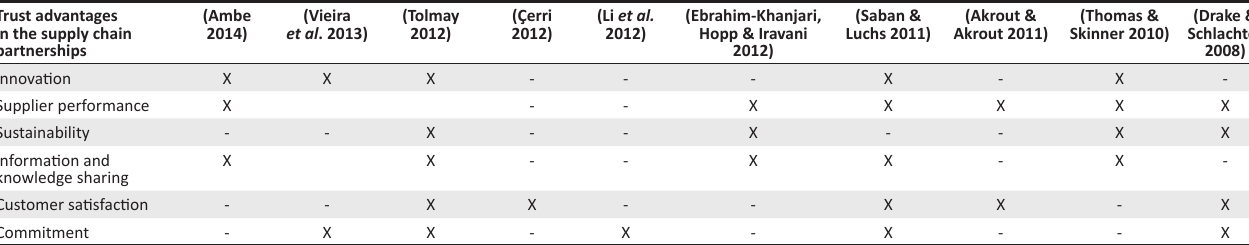
TABLE 2: Trust in the supply chain. Trust advantages in the supply chain